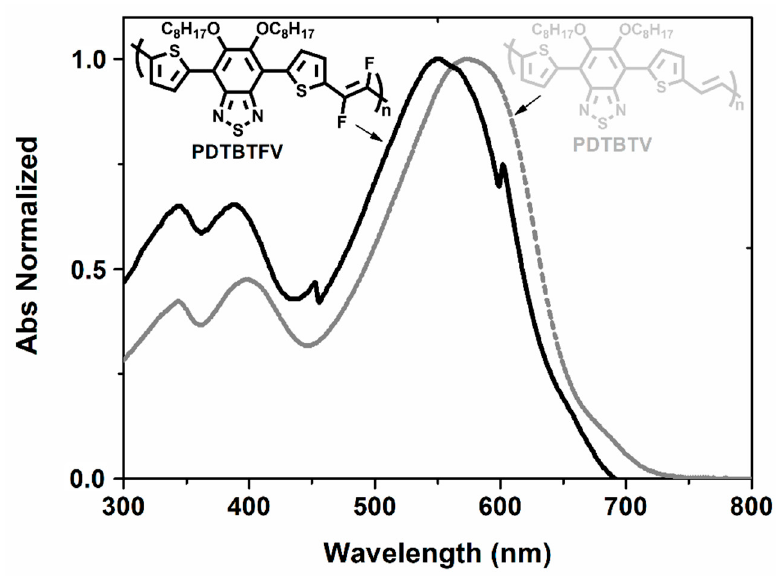
Figure 2. Absorption spectra (normalized) in CHCl 3 solution of polymers PDTBTV and PDTBTFV. Both polymers absorb in a wide range of the visible region, with maxima picked at 548 nm (2.26 eV) for PDTBTFV and 569 nm (2.18 eV) for PDTBTV , with a blue-shift of about 21 nm (0.08 eV) induced by fluorination of vinylene units. According with the results of the TD-DFT calculations, the blue-shift is a result of the mesomeric and inductive effects of fluorine atoms. In the solid state, ellipsometry investigations showed the same trend in the absorption spectrum observed in solution, with an optical band gap of the films of polymers found at 1.79 eV for PDTBTFV and 1.69 eV for PDTBTV . The HOMO and LUMO energy levels were investigate by cyclic voltammetry, and based on the Koopmans’ theorem, they were estimated to be HOMO − 5.20 eV for PDTBTFV and − 5.01 for PDTBTV , LUMO − 3.14 for PDTBTFV and − 3.03 for PDTBTV . These data reveal an overall stabilization of both HOMO and LUMO energy levels induced by fluorination of vinylene units,